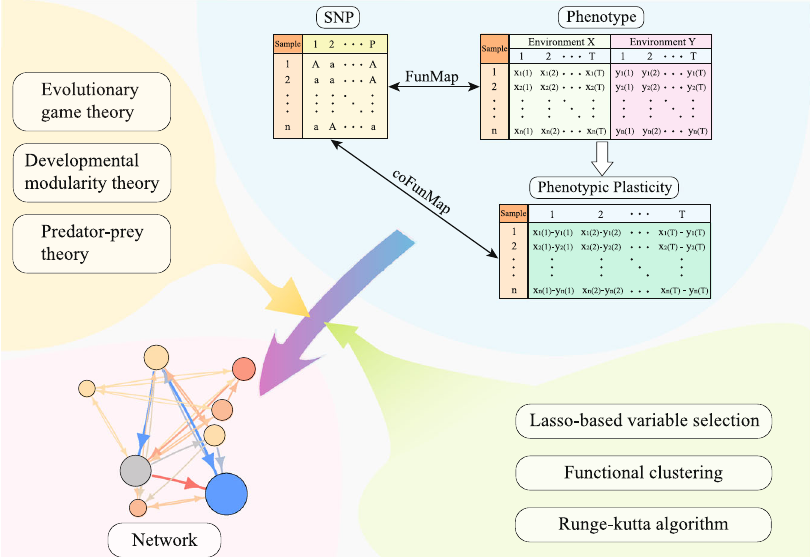
Fig. 1 Flowchart of model derivation with genetic data and time-series phenotypic data in two environments X and Y as inputs. Environment-speci fi c phenotypes are used to calculate phenotypic plasticity, which is mapped by coFunMap, an extension of single-trait functional mapping (FunMap) to a composite trait. coFunMap is integrated with elements of evolutionary, ecological, and developmental disciplines to reconstruct maximally informative (bidirectional, signed, and weighted) interaction networks by implementing high-dimensional statistical and mathematical methods. In the network, line arrow represents the direction of regulation by one SNP (node) to the next, line color denotes the sign of regulation (warm for promotion, cold for inhibition), and color metric indicates the strength of